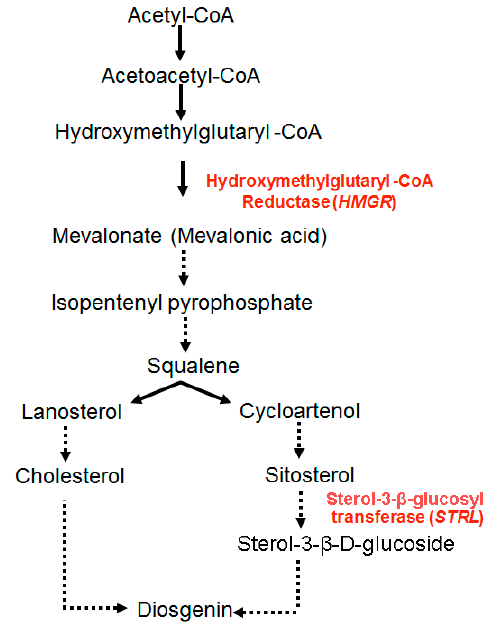
Figure 3. Proposed diosgenin biosynthetic pathway. 3-Hydroxy-3-methylglutaryl-CoA is converted to mevalonate by 3-hydroxy-3-methylglutaryl-CoA reductase (HMGR) enzyme. This is the major rate limiting step of isoprenoid pathway. Mevalonate is converted to isopentenyl pyrophosphate via series of multiple reactions. Then, diosgenin is produced from squalene by two routes: via cholesterol from lanosterol and via sitosterol from cycloartenol to sterol 3- β - D -glucoside. Finally, the latter is converted to diosgenin by sterol 3- β -glucosyl transferase (STRL) enzyme (dashed lines indicate multiple steps involved in the pathway; arrows indicate the flow of reaction in pathway).